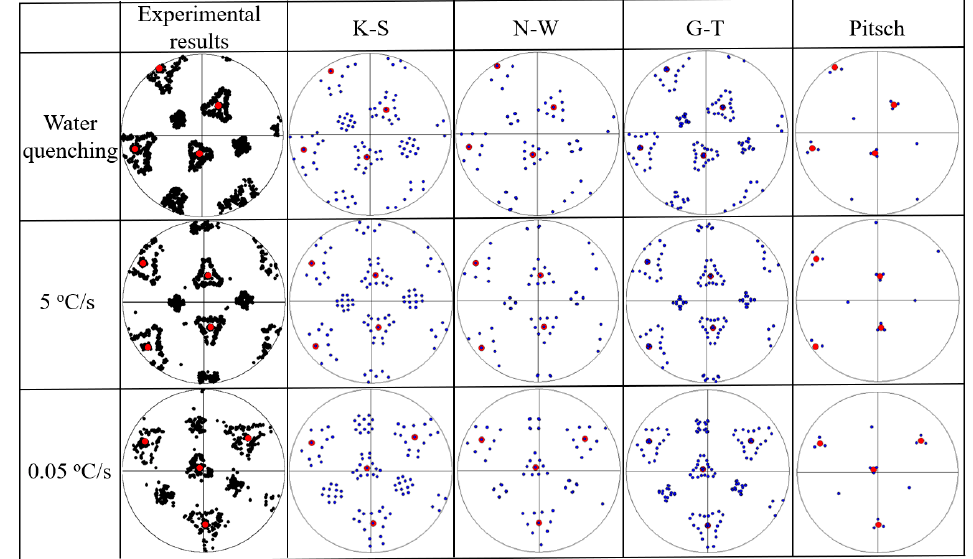
Figure 4. Pole figures of martensitic and bainitic variants. First column: experimental results of {011} bcc pole figures. Simulated K-S, N-W, G-T, and Pitsch variants are listed in the second, third, fourth and fifth column, respectively. The {111} fcc planes are indicated by red points, while all possible variants are represented by black and blue spots.